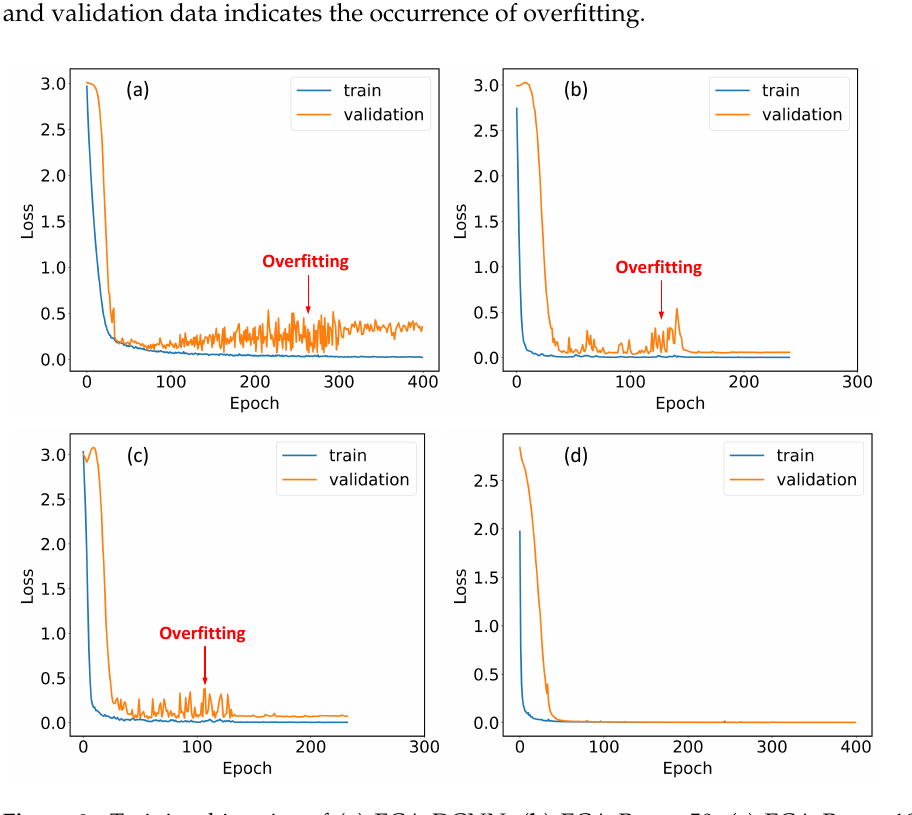
Figure 8. Training histories of ( a ) ECA-DCNN, ( b ) ECA-Resnet50, ( c ) ECA-Resnet101, and ( d ) ECA